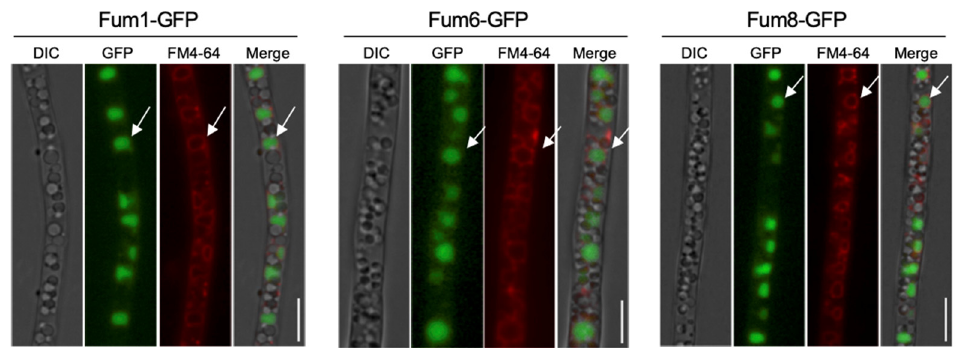
Figure 2. Subcellular localization of Fum1-GFP, Fum6-GFP, or Fum8-GFP with FM4-64 on vacuoles. Fluorescent images indicate co-localization of Fum1-GFP, Fum6-GFP, or Fum8-GFP with FM4-64 labeling on vacuoles. Arrows indicate co-localization. Bars = 5 μ m.